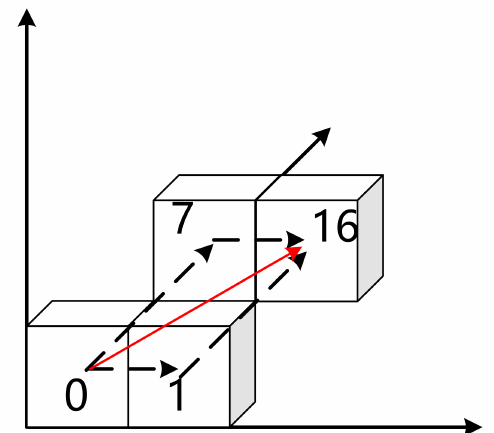
Figure 7. The “+” operation of GeoSOT-3D